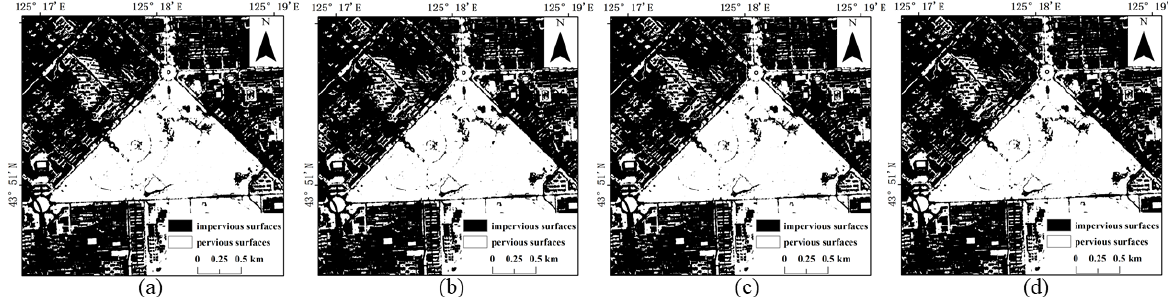
Figure 8. Results of impervious surface extraction with GBDA: ( a ) 40,000 samples; ( b ) 60,000 samples; ( c ) 80,000 samples; ( d ) 100,000 samples.